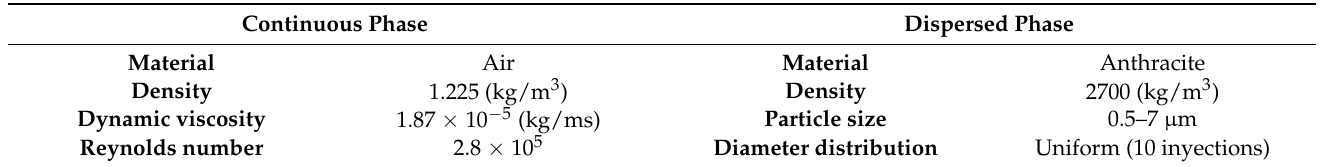
Table 6. Properties of the continuous and dispersed phase.